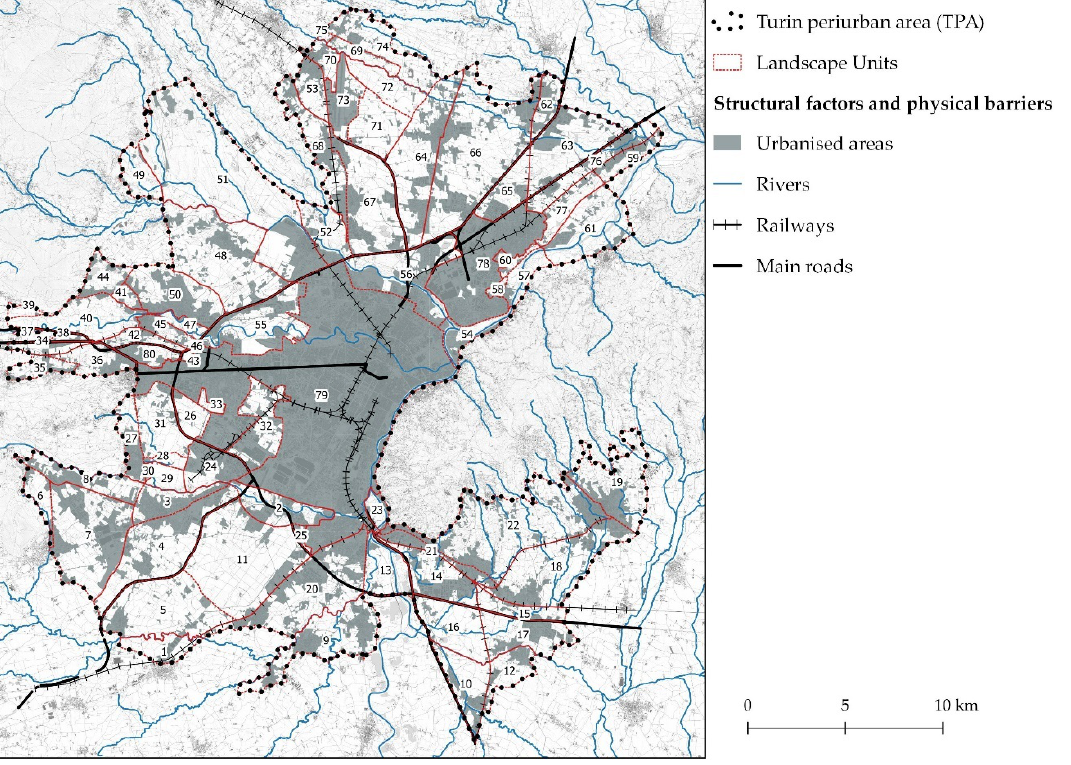
Figure 5. Map of the spatial classification of peri-urban landscape units.